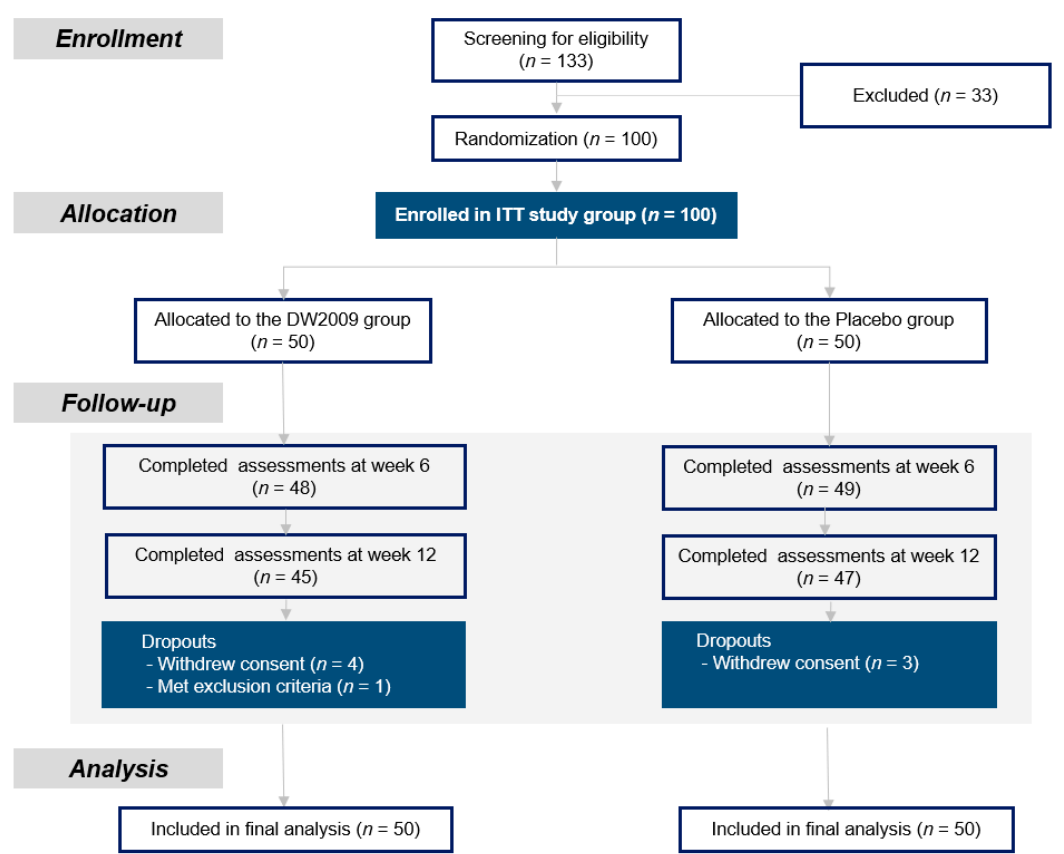
Figure 1. Screening, randomization, and allocation of participants to the DW2009 or placebo groups.